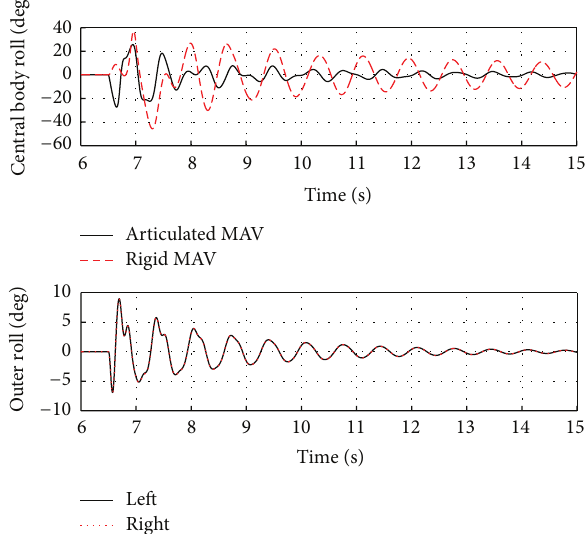
Figure 11: Rigid and articulated MAV center and outer body roll in response to a 2m/s crosswind gust.